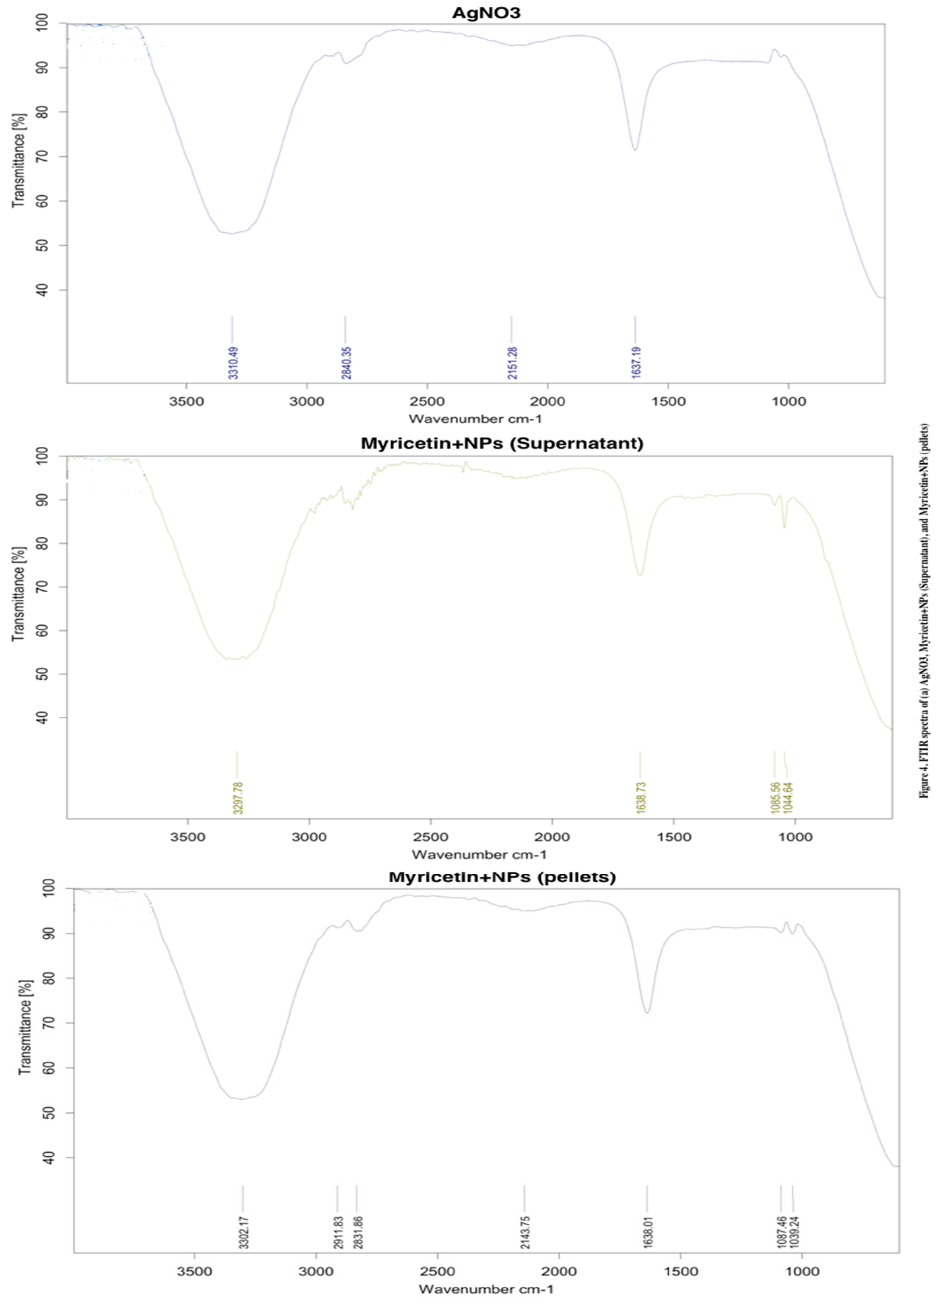
Figure 4. FTIR spectra for myricetin with and without NPs. 2.3. Human Colorectal Cancer Cells’ Vitality Was Decreased by Myricetin